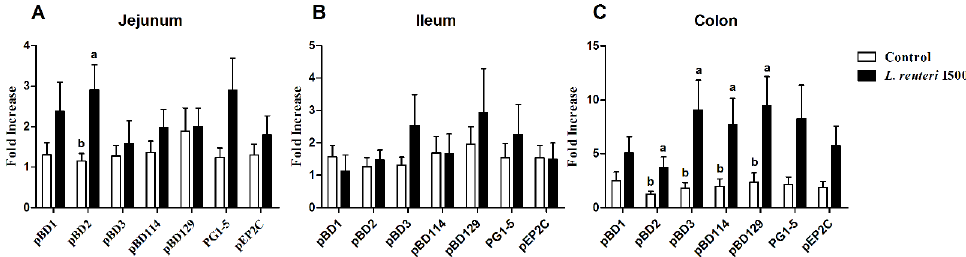
Figure 3. Regulation of pBD1, pBD2, pBD3, pBD114, pBD129, PG1-5, and pEP2C expression by L. reuteri I5007 in the ( A ) jejunum, ( B ) ileum, and ( C ) colon of neonatal piglets. Twenty-two male neonatal piglets were orally administrated with 0.1% peptone solution (control) or 1 × 10 10 CFU of L. reuteri I5007 daily for 20 days. Gene expression was analyzed by real-time PCR. The relative fold changes over the control were calculated with the ∆∆ C t method using the β -actin gene for normalization. White bars or black bars represent control or L. reuteri I5007 treatments, respectively. Values are presented as mean ± standard error of the mean, n = 11 piglets per treatment. Bars with different letters differ, p < 0.05 by unpaired Student’s t